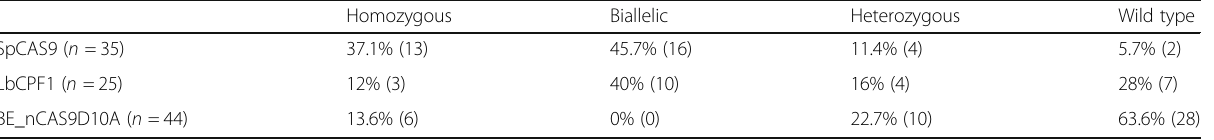
Table 1 Homozygous, heterozygous, biallelic and wild-type plants produced using SpCAS9, LbCPF1 and BE_nCAS9D10A expressed as % of analyzed regenerated